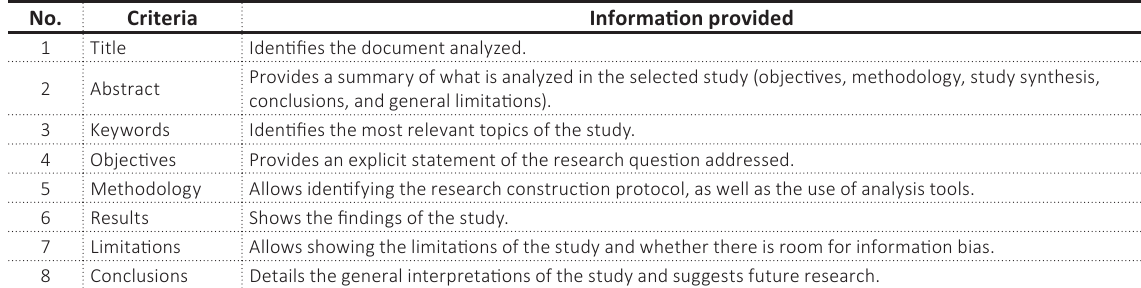
Table 3. Elements included in the